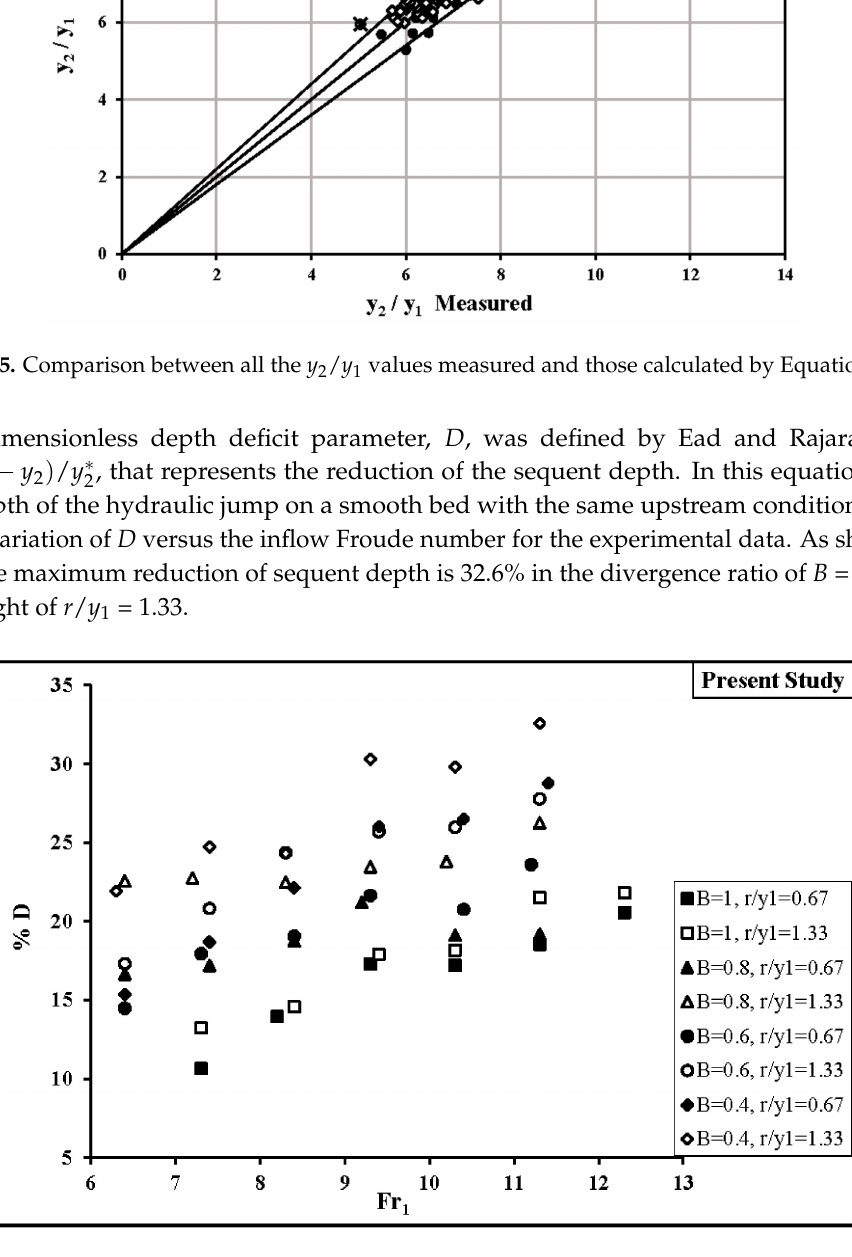
Figure 6. Dimensionless depth deficit parameter D vs. the inflow Froude